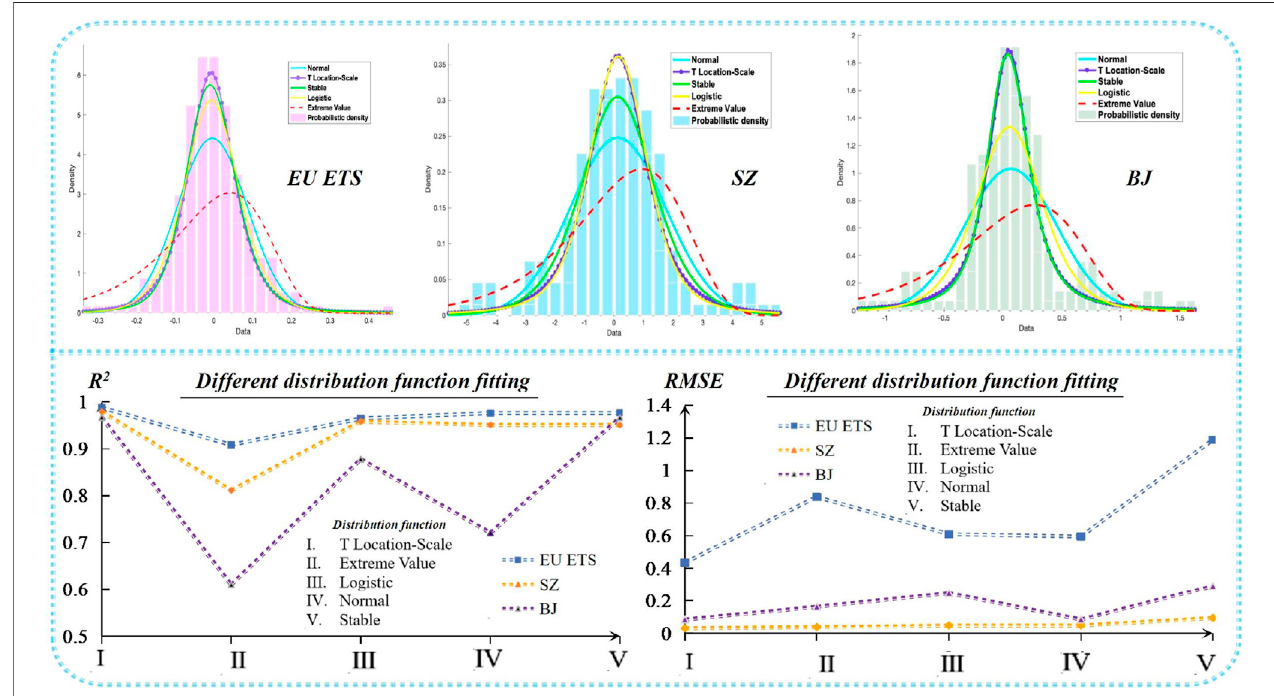
FIGURE 4 | Five distribution functions fi t the distribution of EPS